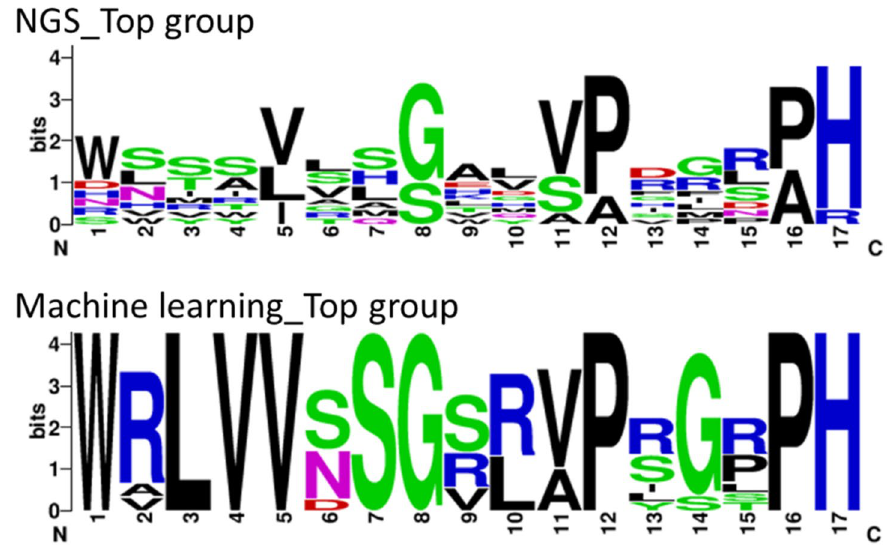
Figure 9. Amino acid compositions of evaluated sequences. Each diversified position is indicated in x-axis (numbering is followed by Table 1). The figures are illustrated by WebLogo (version 2.8.2, https ://weblo go.berke ley.edu/).